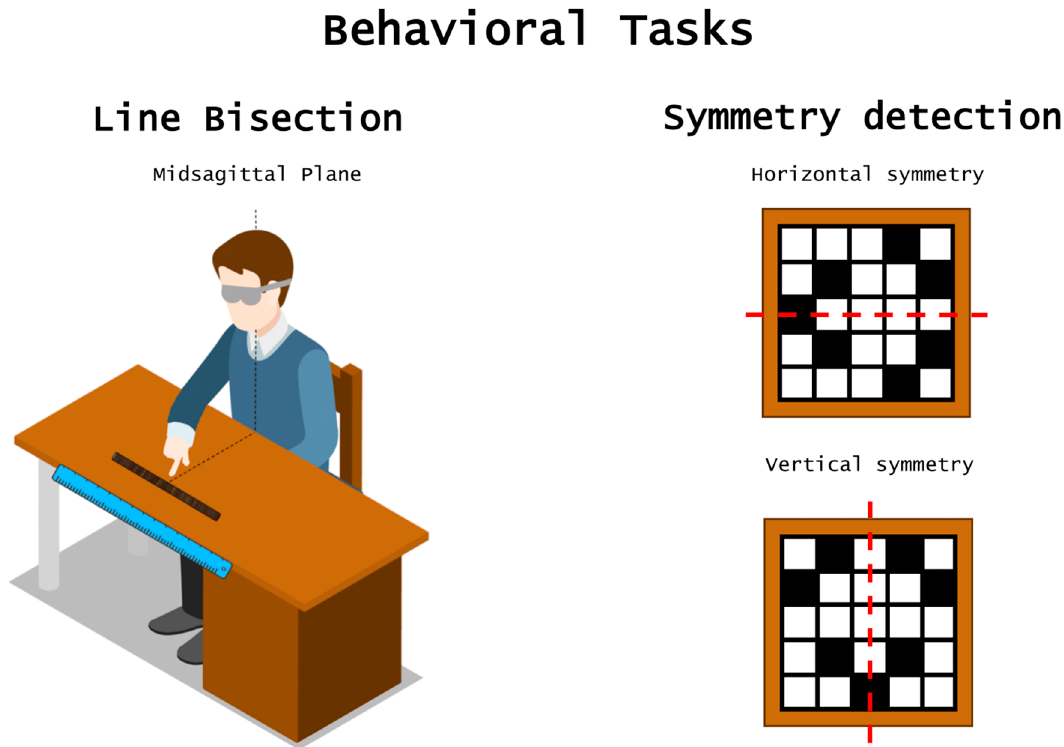
Figure 1. Behavioral tasks used to assess spatial asymmetries. A typical task probing the presence of spatial asymmetries in spatial processing is the haptic line bisection task in which participants are asked to indicate the midpoint of a horizontal rod. Various studies indicate that blind individuals generally show a leftward bias when bisecting the horizontal rod as sighted individuals do. Symmetry detection may be also informative about laterality patterns following visual deprivation. In this case, participants are asked to haptically explore a 2D matrix and must remember the position of target cells, which may be arranged in a symmetrical (i.e., either on the horizontal or vertical axis) or non-symmetrical configuration. Whereas sighted individuals show a clear advantage for symmetry detection along the vertical axis as compared to the horizontal one, no such a difference is observed in early blind individuals.